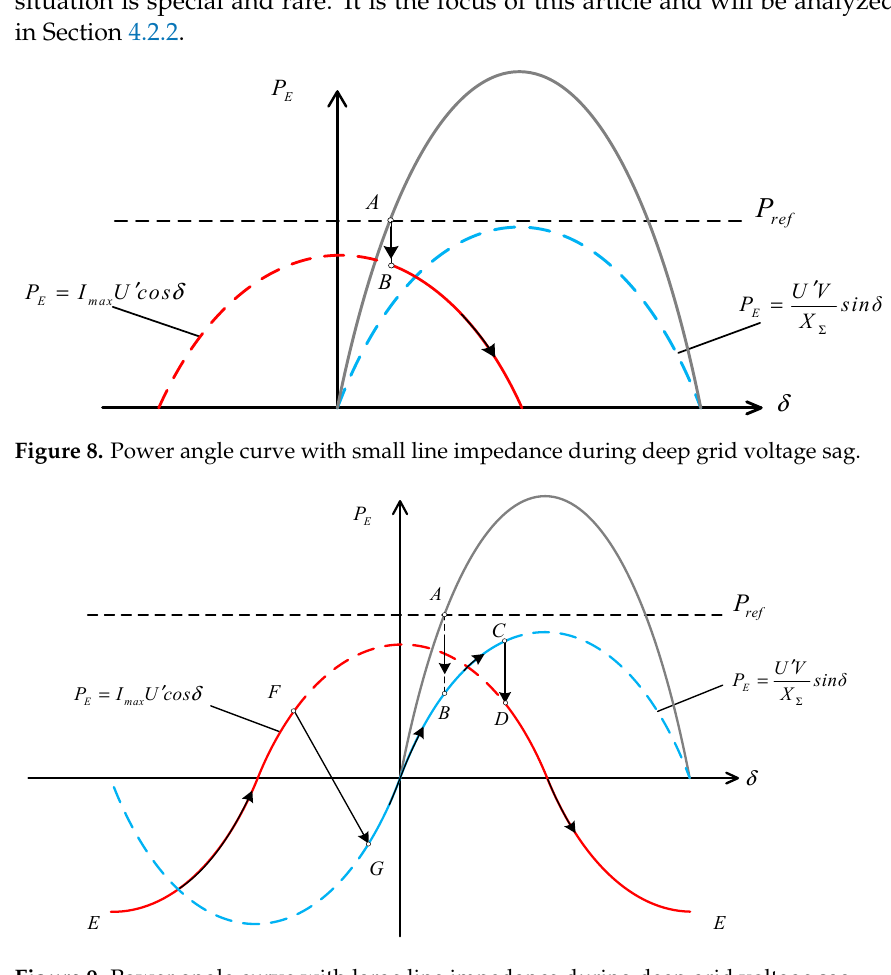
Figure 9. Power angle curve with large line impedance during deep grid voltage sag.